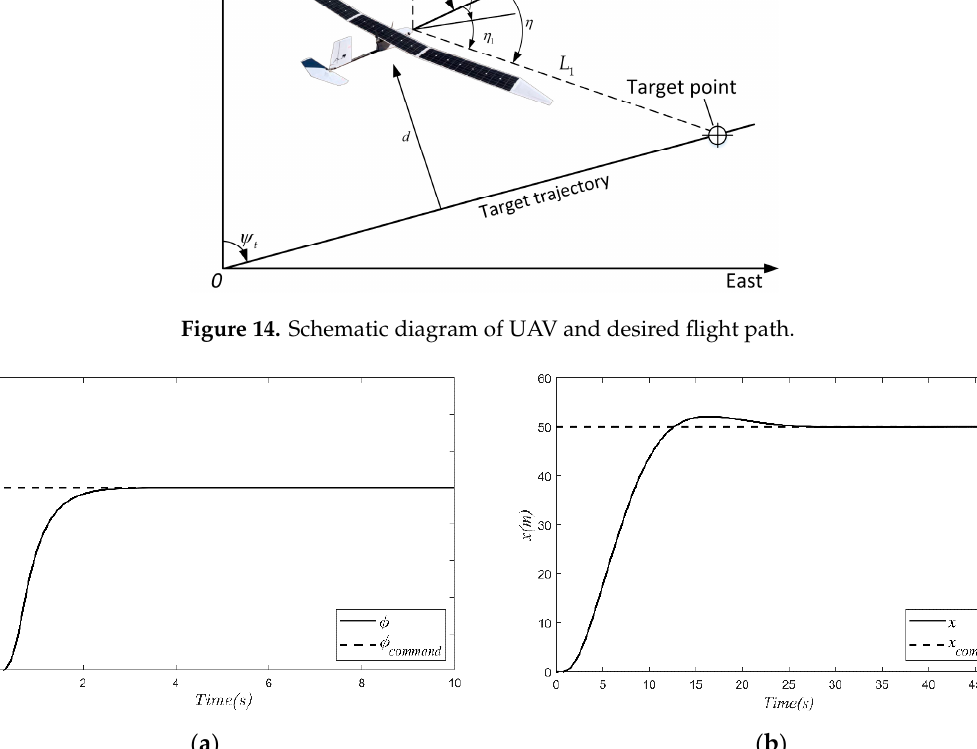
Figure 15. Simulation of straight-line trajectory tracking: ( a ) Roll angle command tracking, ( b ) lateral distance command tracking.